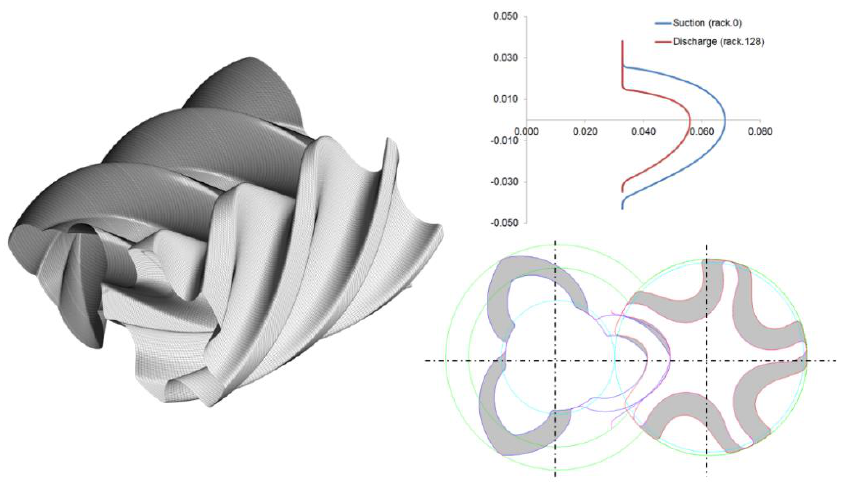
Figure 9. Variable profile screw rotor grid with 3/5 ‘N’ profile [1,7].